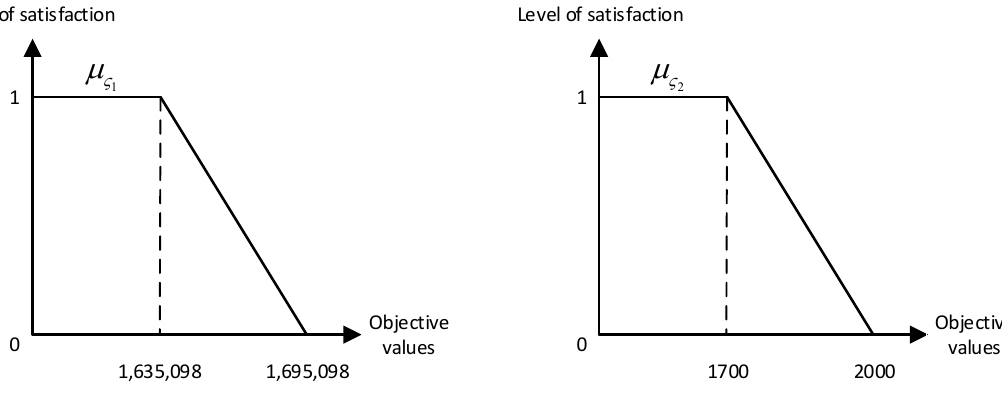
Figure 2. Linear membership functions for ζ 1 and ζ 2 when α =